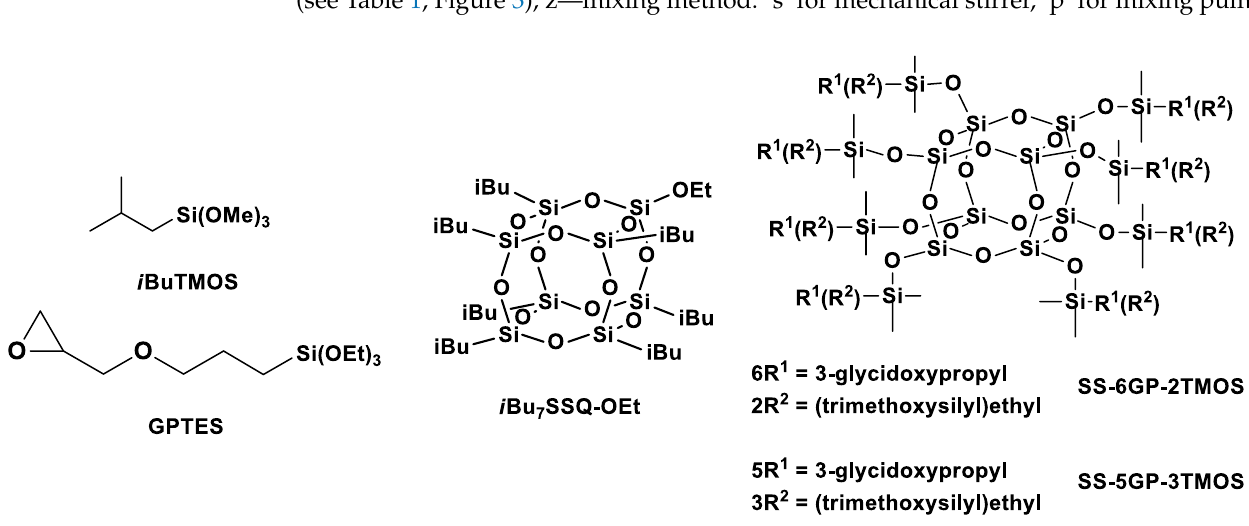
Figure 3. Structures of the silane and cage siloxane compounds studied in this work. Table 2. The TiO 2 /epoxy resin composites prepared in this study.